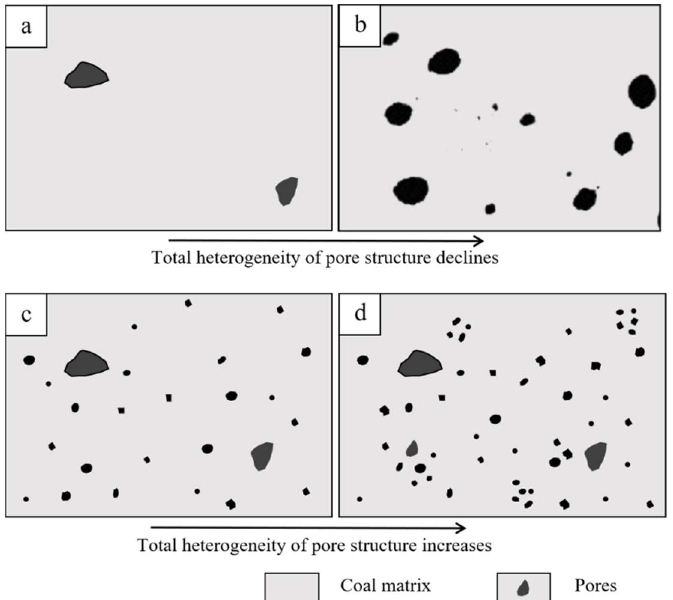
Figure 11. The pore development of different scales and its influence on pore structure heterogeneity. (( a , b ), total heterogeneity of pore structure declines with the increase of pore development; ( c , d ), total heterogeneity of pore structure increases with the increase of pore development)